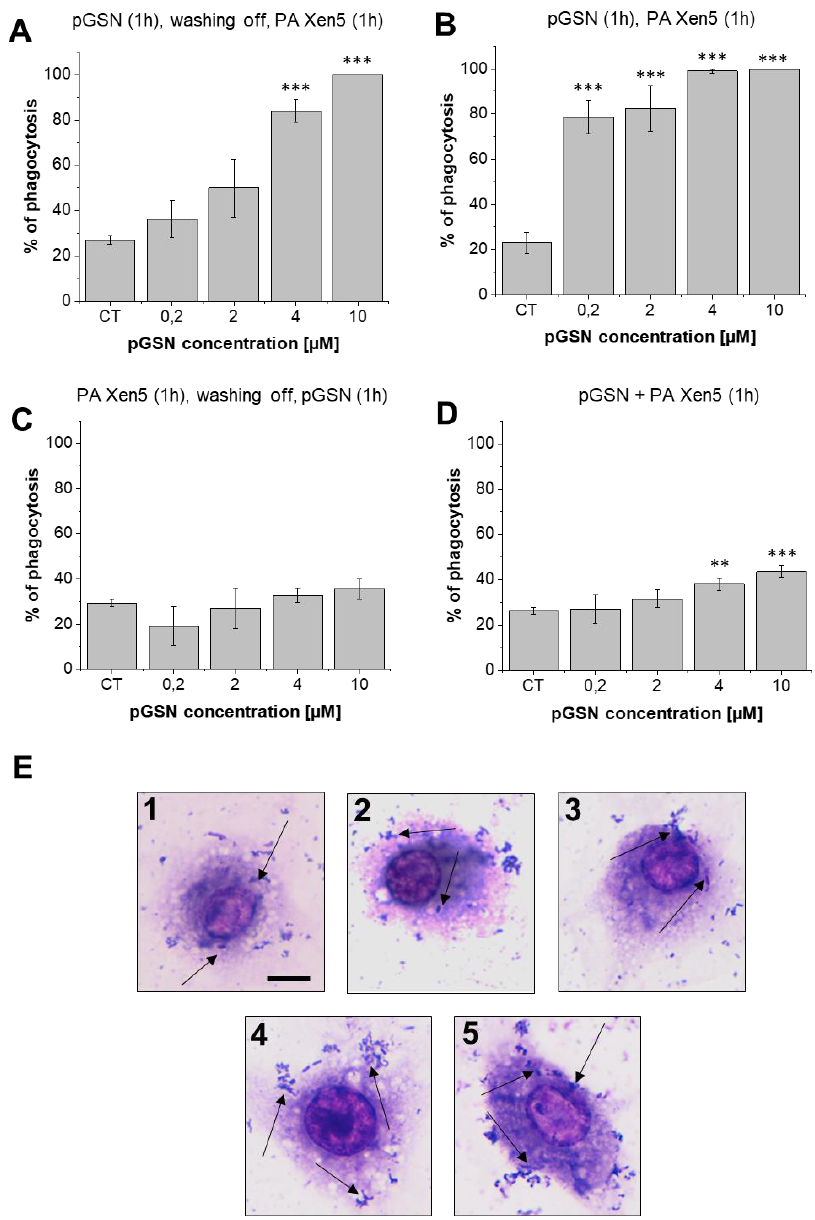
Figure 7. pGSN-mediated stimulation of phagocytosis by RAW264.7 in in vitro settings. Effect of exogenous pGSN on internalization of PA Xen 5 by macrophages, when administrated in varied combinations with bacterial suspension: pGSN (0.2–10 µM) incubation for 1 h, washing off and PA